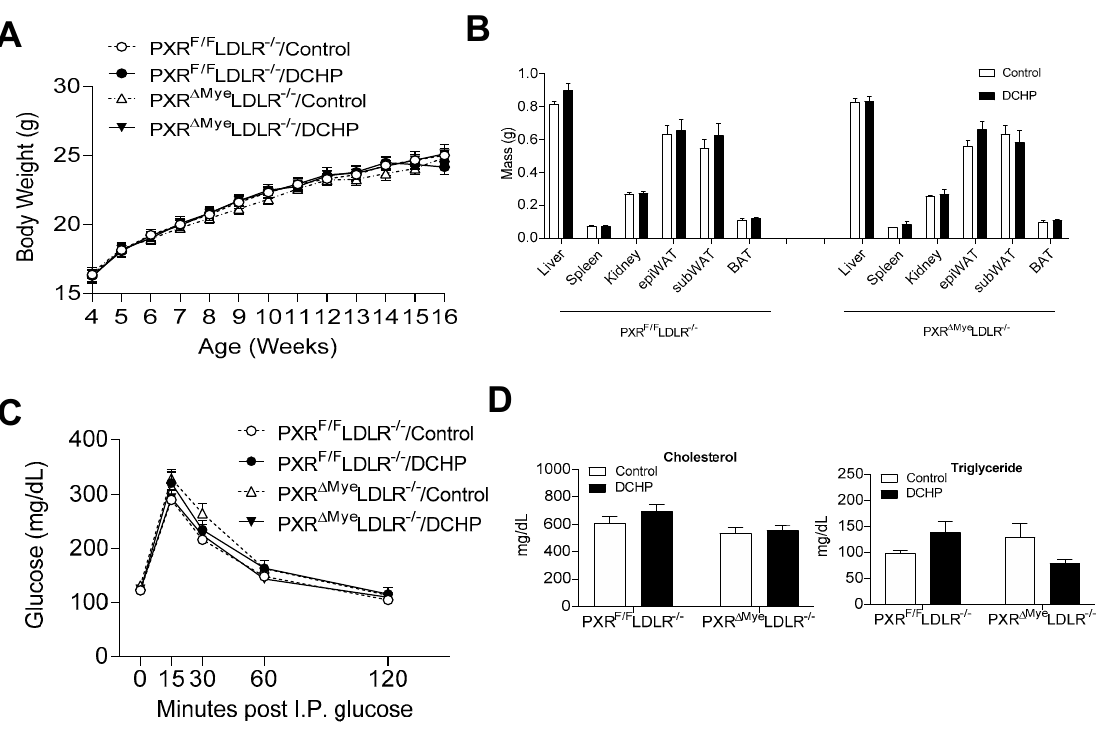
Figure 1. DCHP exposure does not affect metabolic phenotypes and plasma lipid profiles in LDLR − / − mice. Four-week-old male PXR F/F LDLR − / − and PXR ∆ Mye LDLR − / − littermates were treated with 10 mg/kg/day of DCHP or vehicle control daily by oral gavage for 12 weeks. Growth curve ( A ), major organ weight ( B ), glucose tolerance ( C ), and serum cholesterol and triglyceride levels ( D ) were measured. Data are represented as mean ± SEM (n = 6–12). subWAT, subcutaneous white adipose tissue; epiWAT, epididymal white adipose tissue; and BAT, brown adipose tissue.